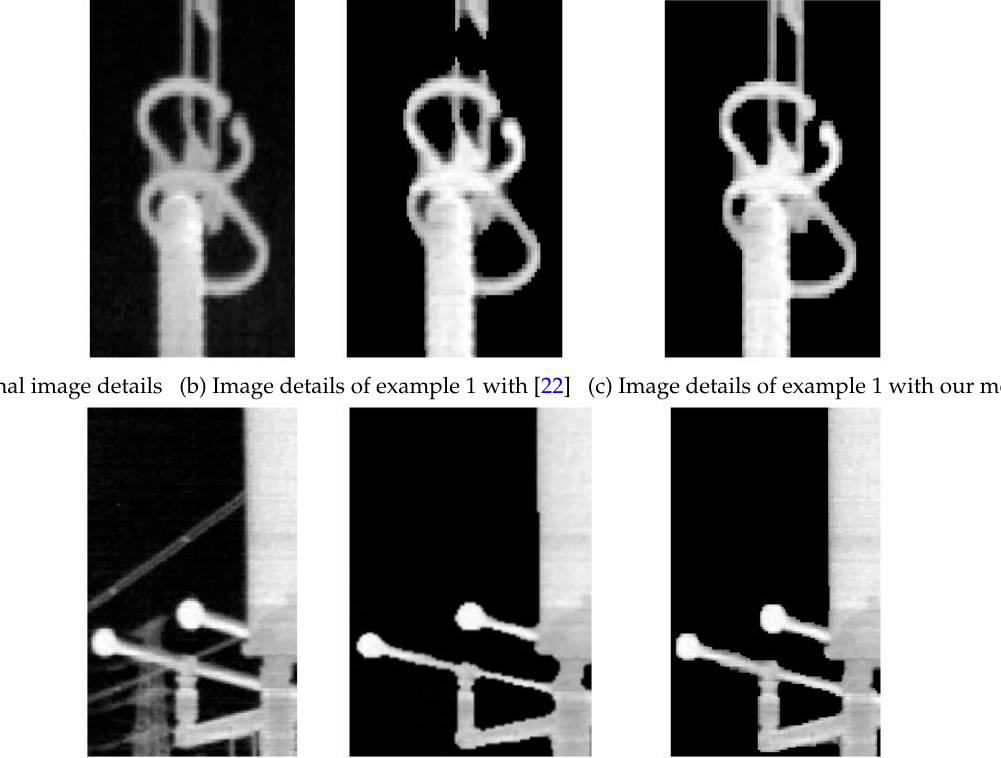
Fig. 6. Comparisons of model